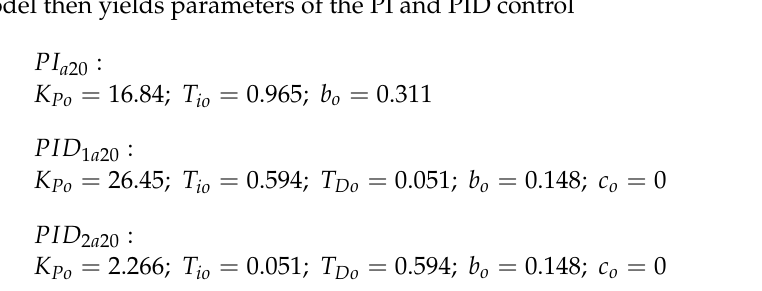
Table 1) just confirm the previously discussed properties: PI control and the first option of PID control show slight output overshooting and an additional control pulse at the input. Monotonic output changes correspond just to the 2nd set of controller parameters